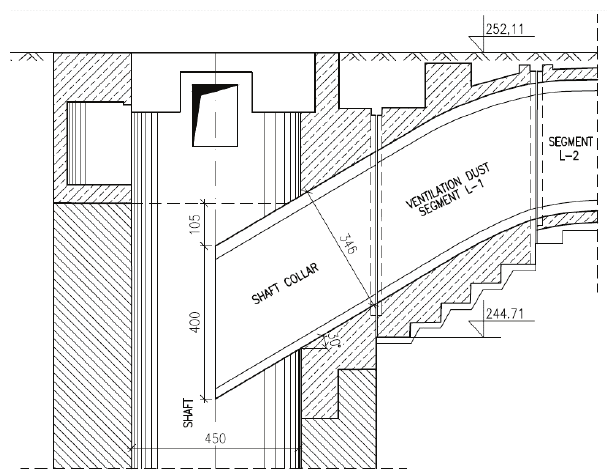
Fig. 1. Longitudinal section drawing of the ventilation duct and shaft collar